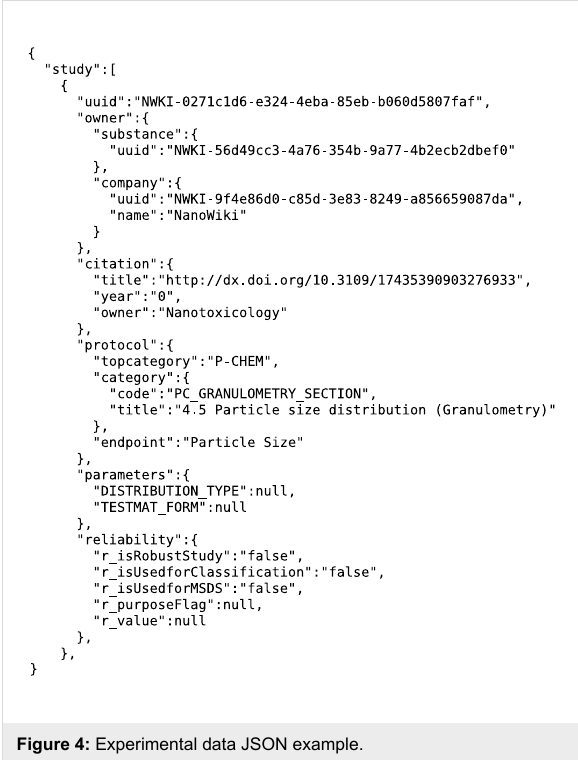
Figure 4: Experimental data JSON